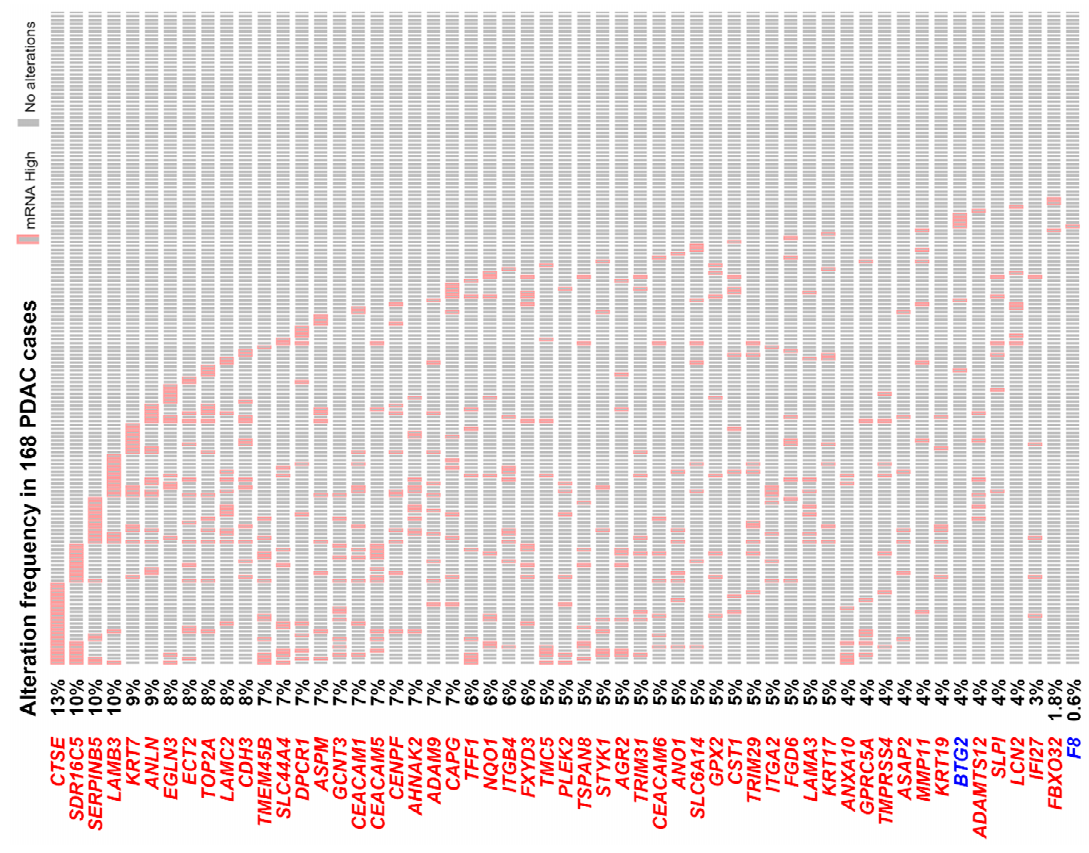
Figure 3. A waterfall plot for the common gene signature expression in “The Cancer Genome Atlas— Pancreatic adenocarcinoma” data set. Genes highlighted in red or blue color indicate those commonly upregulated or downregulated in pancreatic ductal adenocarcinoma (PDAC) patients, respectively. The cases highlighted in red grids (labeled as “mRNA High”) indicate those with mRNA expression higher than that of the average patient (z-score >2).